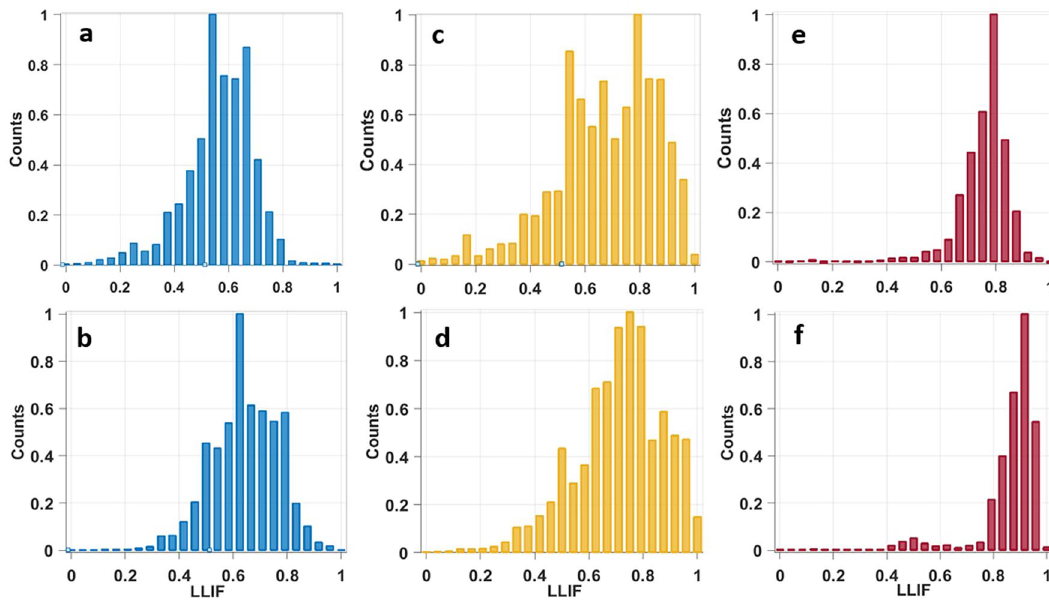
Figure 8. Long lifetime intensity fraction (LLIF) histogram of NADH ( a , c , e ) and FAD ( b , d , f ) issued from phasor FLIM analysis at 810 nm for Control ( a , b ), grade I meningioma ( c , d ) and grade II meningioma ( e , f